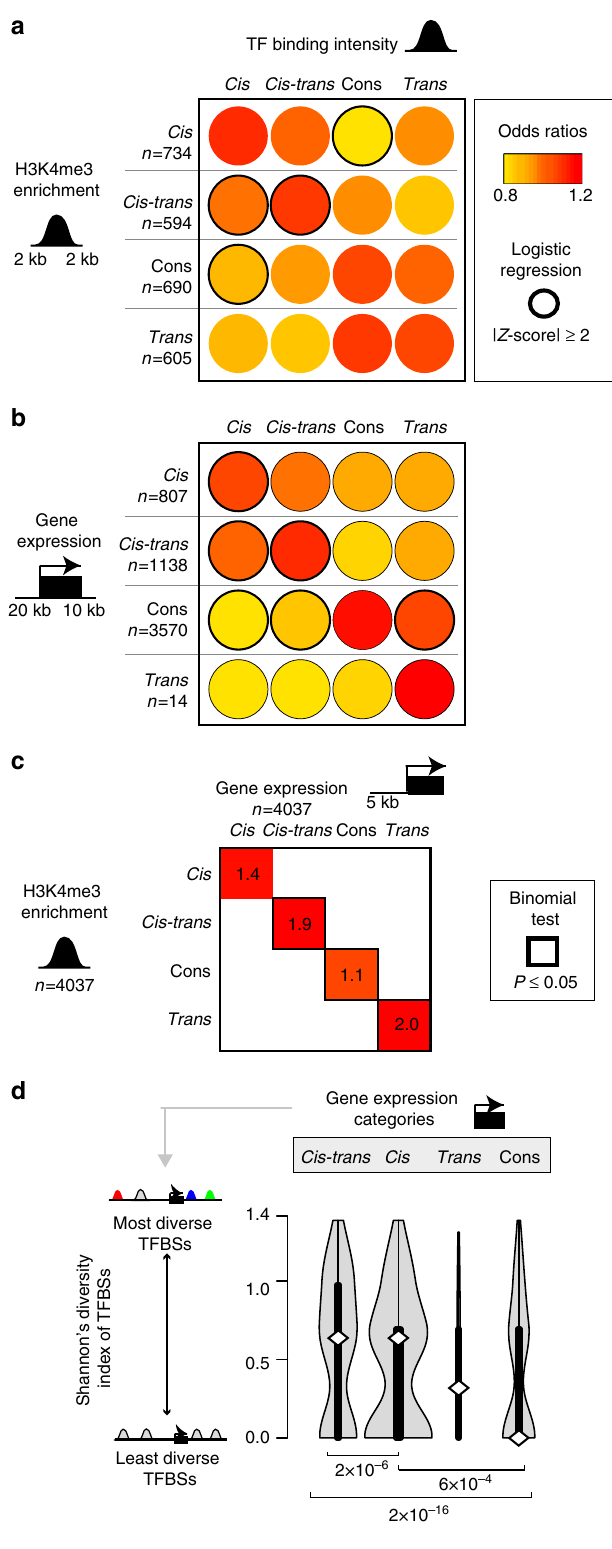
between genes grouped by transcriptional regulatory class. Signi fi cant P -values for Mann – Whitney U -tests are shown. The surface area of